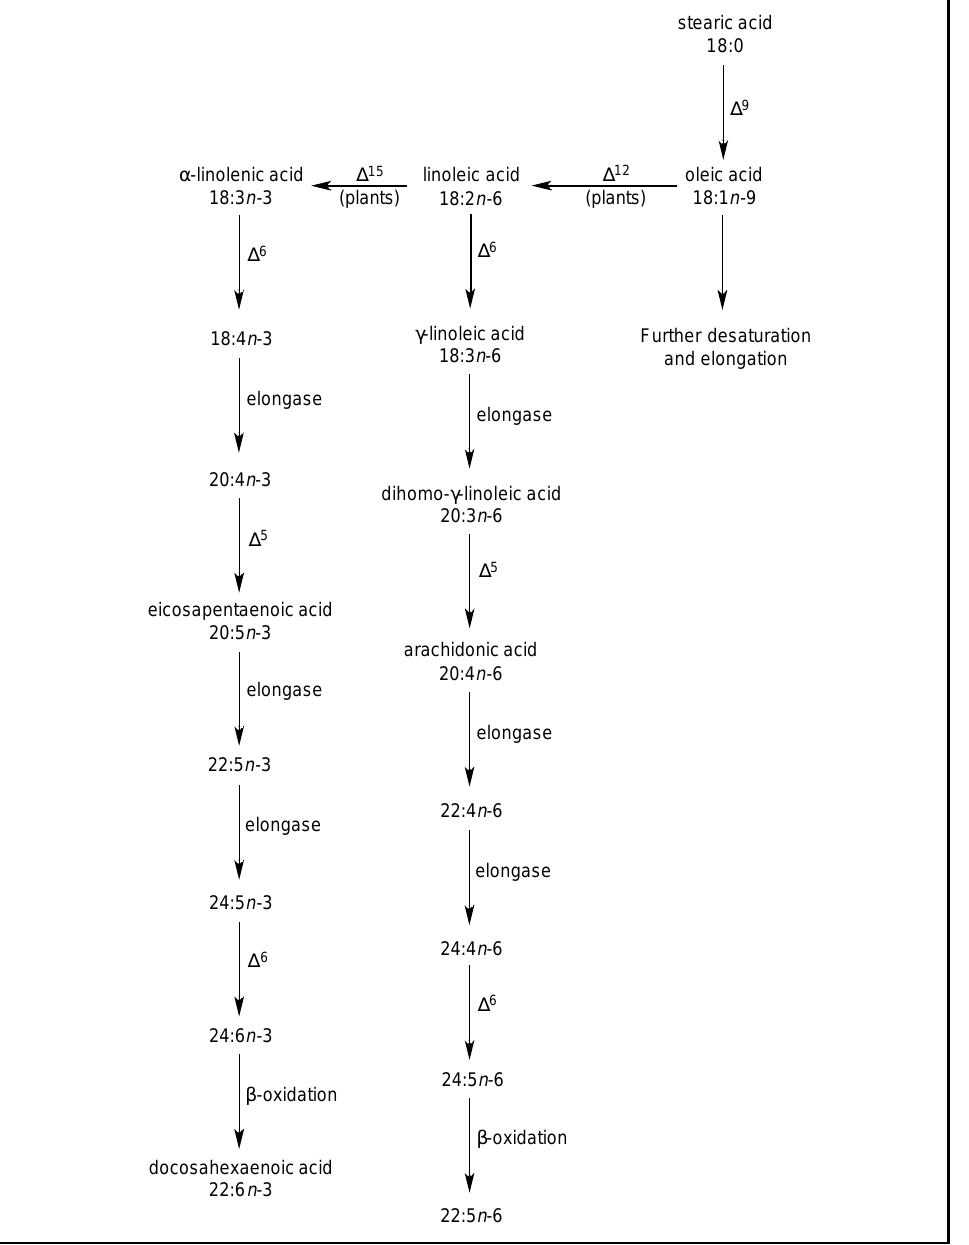
Figure 1 - PUFA metabolism. D 5 , D 6 , D 9 , D 12 and D 15 indicate desaturase